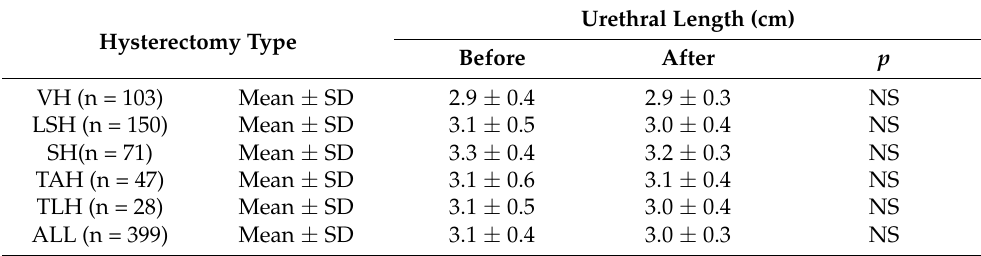
Table 3. Urethral length among the study group patients before and after hysterectomy. Hysterectomy